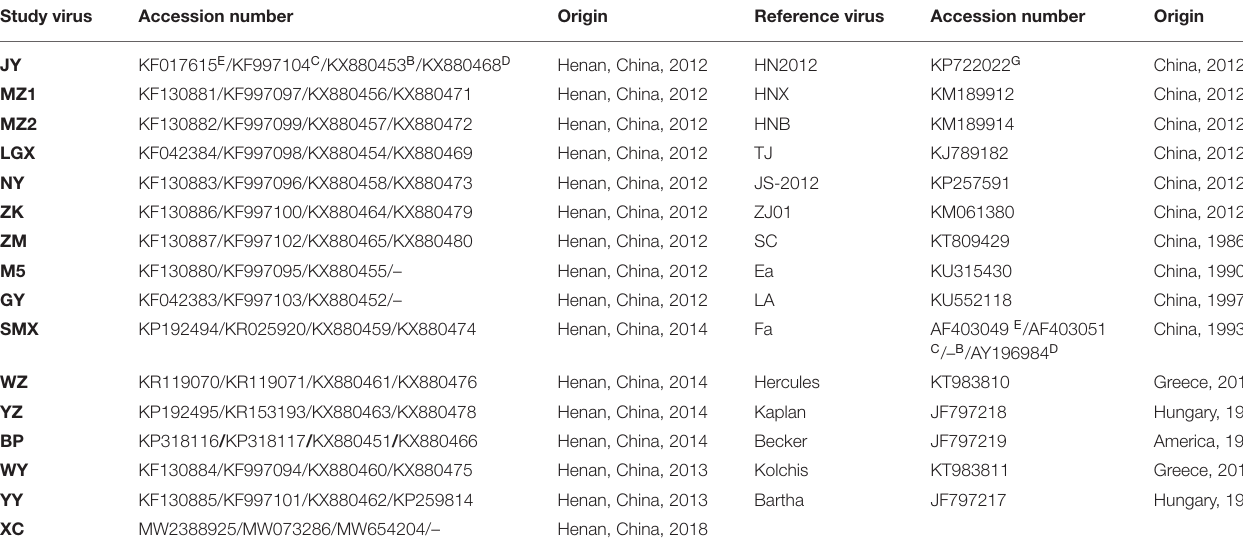
TABLE 1 | The information of PRV strains for sequence alignment and phylogenetic analysis.